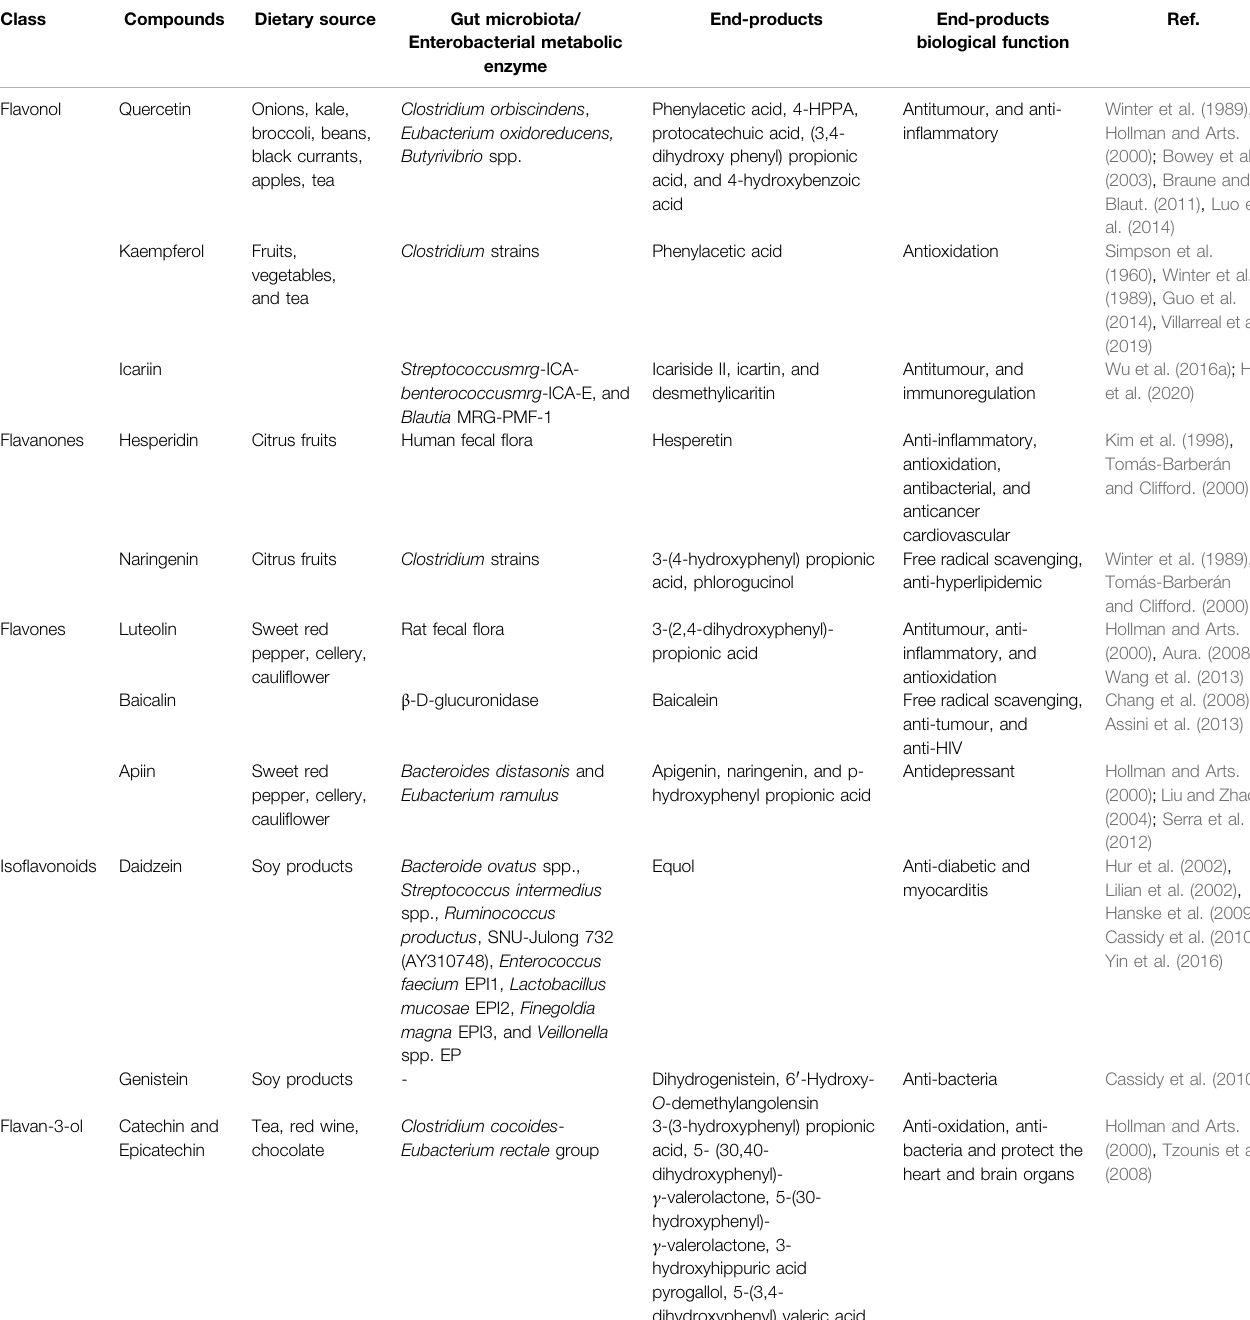
TABLE 1 | The interaction of fl avonoids and gut